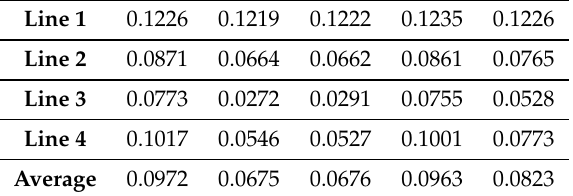
Table 1. Location error in different positions